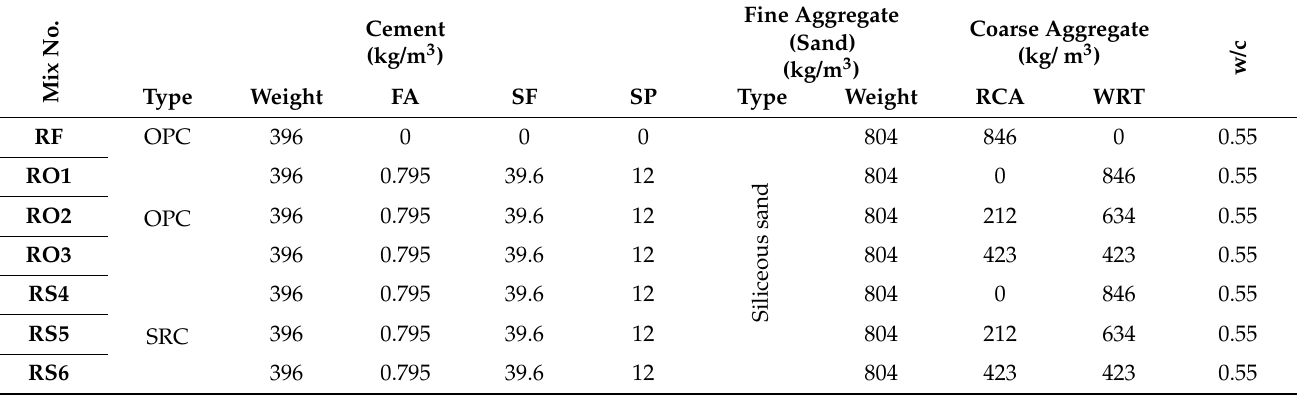
Table 5. Mix proportions for rubberized concrete